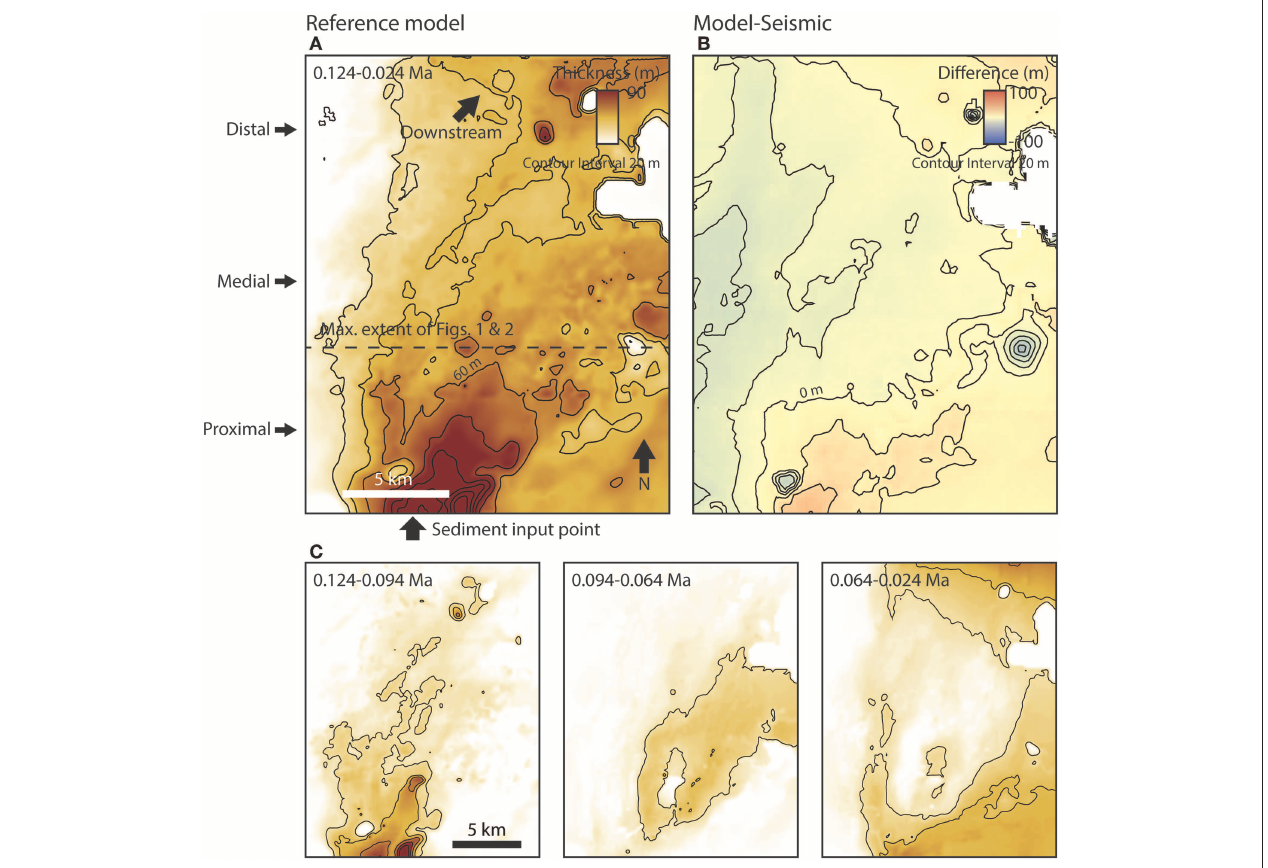
FIGURE 3 | New extended reference-case model. (A) Isochore map of the new model. (B) Difference in thickness of the model and the slope fan in block 25A, offshore Trinidad (Hawie et al., 2018). (C) Isochore maps of depositional sequences within the model showing major phases of sediment diversion.